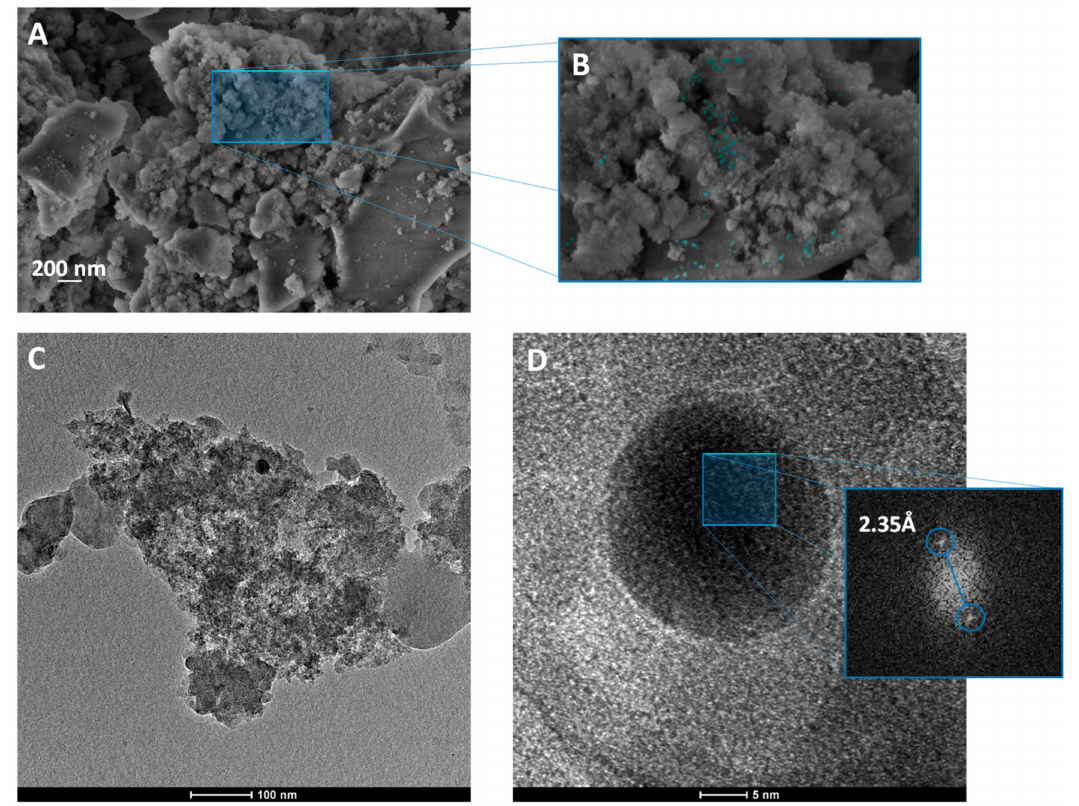
Figure 6. ( A , B ) FE-SEM images of SiO2-Ag and ( C , D ) TEM and HR-TEM of SiO2-Ag